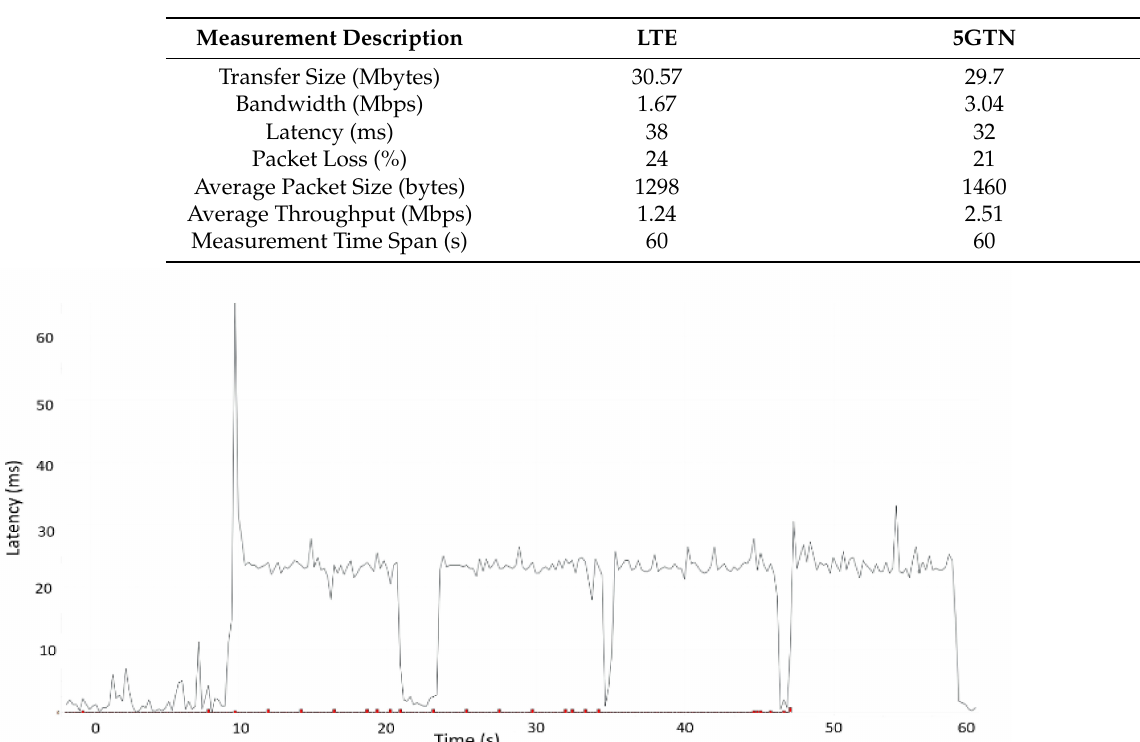
Table 3. Comparative analysis between 5GTN and LTE.